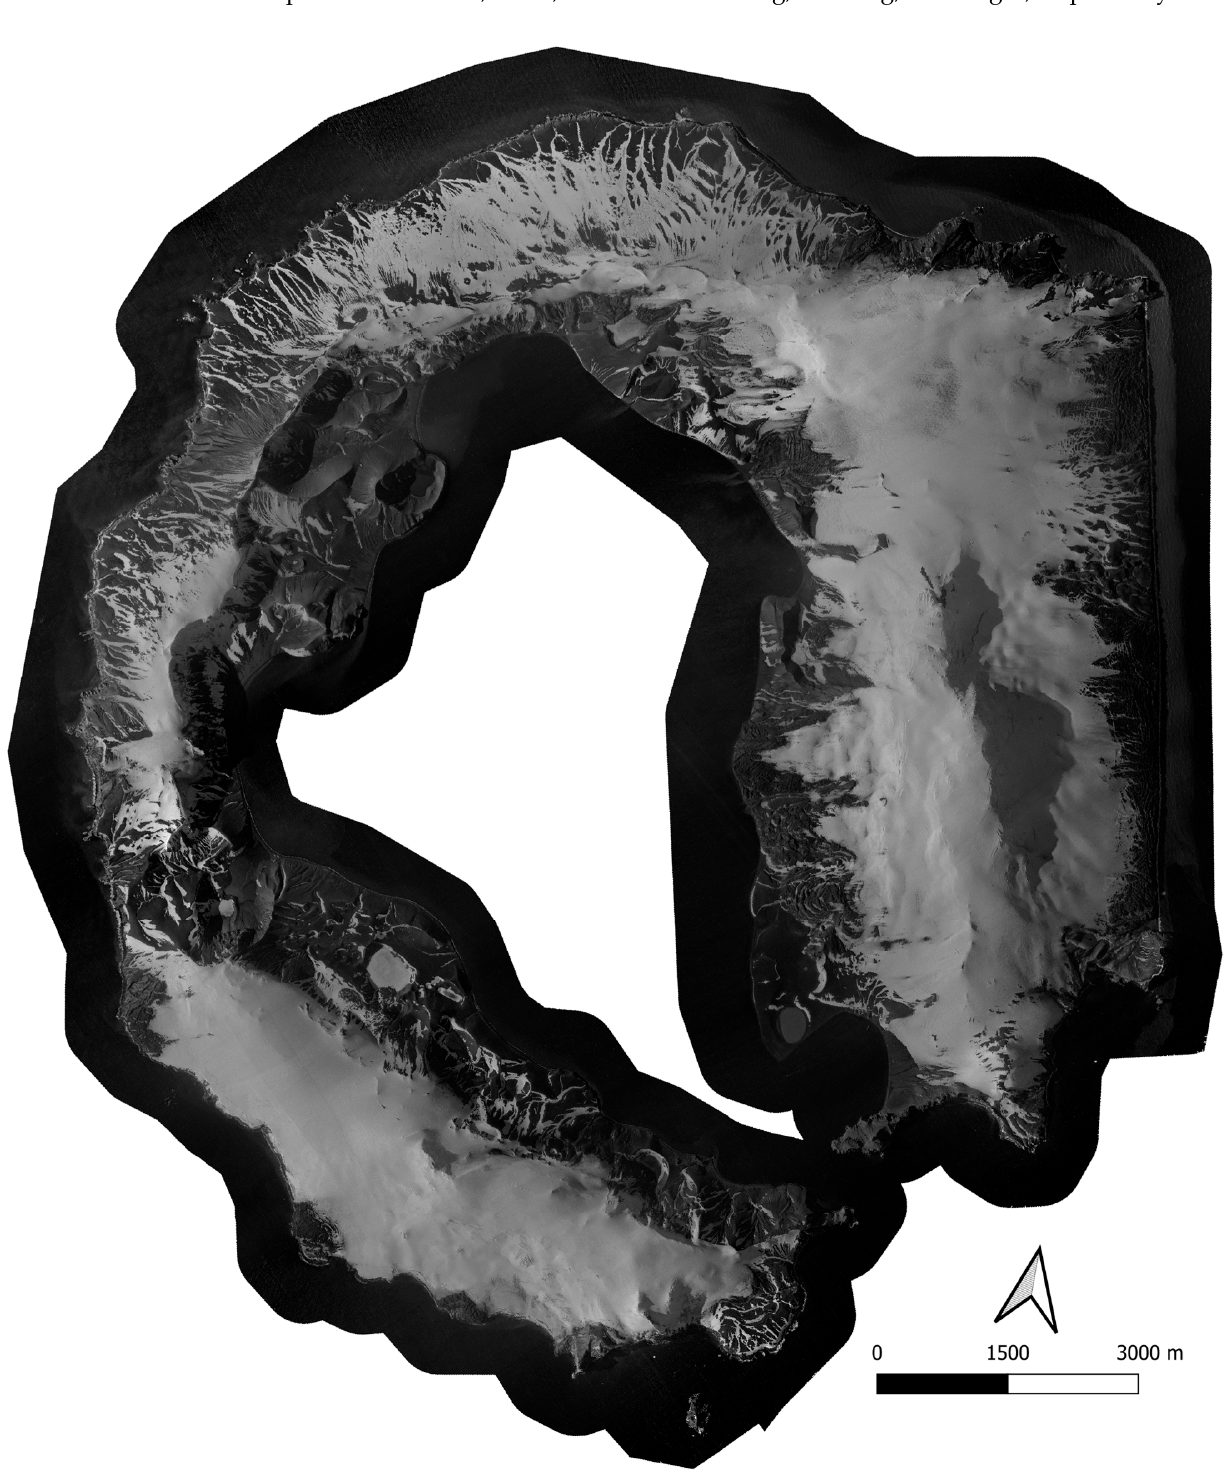
Figure 2. Orthographic mosaic of 1956, before the 1967–1970 eruptive sequence, in black and white, corrected with the computed digital elevation model using SfM–MvS strategies. Both sets of stereo pairs from 1956 were processed together, increasing the degree of overlap and enhancing the dense point cloud resolution and digital elevation model precision. However, only the historical aerial frames set without clouds were used to generate this 1956 orthographic mosaic.